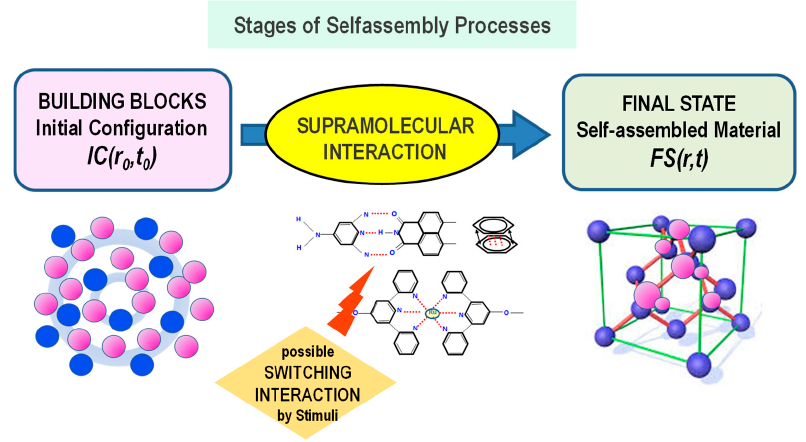
Figure 1. Conceptual scheme indicating the main stages of the self-assembly process in